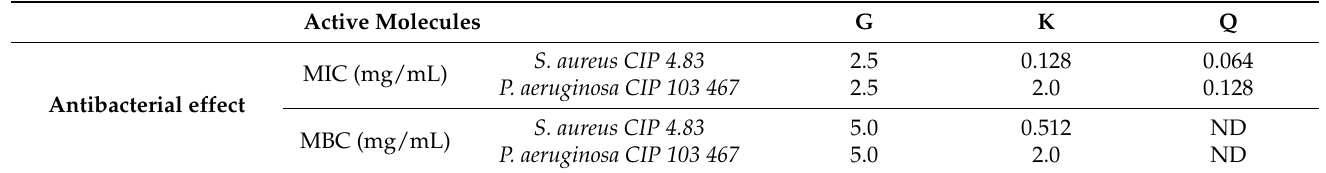
Table 1. Antibacterial activity of active molecules (MIC—minimum inhibitory concentration; MBC —minimum bactericide